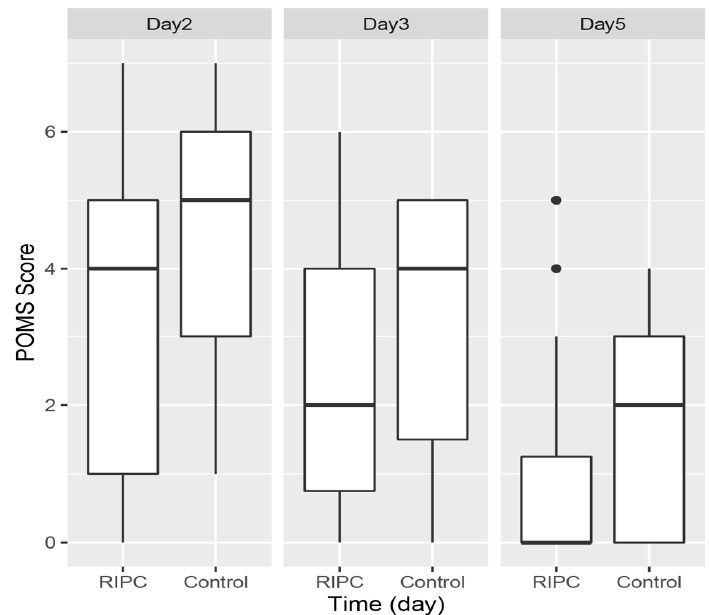
Figure 2. Boxplot of Postoperative Morbidity Survey (POMS) score on day 2 (4 [1, 5] vs. 5 [3, 6], adjusted p = 0.185), day 3 (2 [0.75, 4] vs. 4 [1.5, 5], adjusted p = 0.226) and day 5 (0 [0, 1.25] vs. 2 [0, 3], adjusted p = 0.159), in the intervention (RIPC) and control groups.